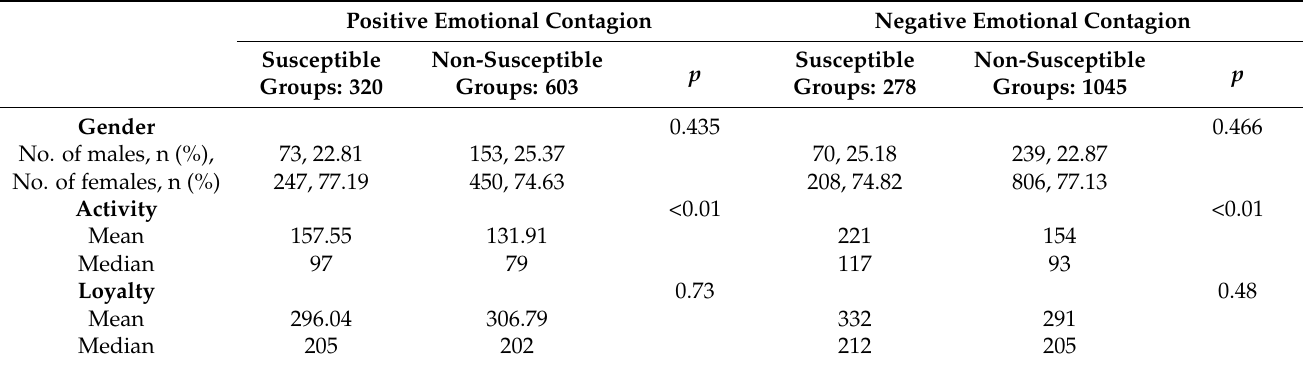
Table 2. Characteristics of the susceptible population.